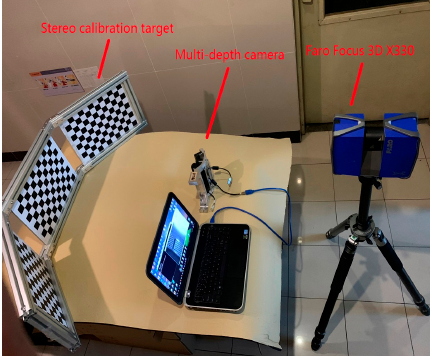
Figure 3. Multiple depth camera systems.